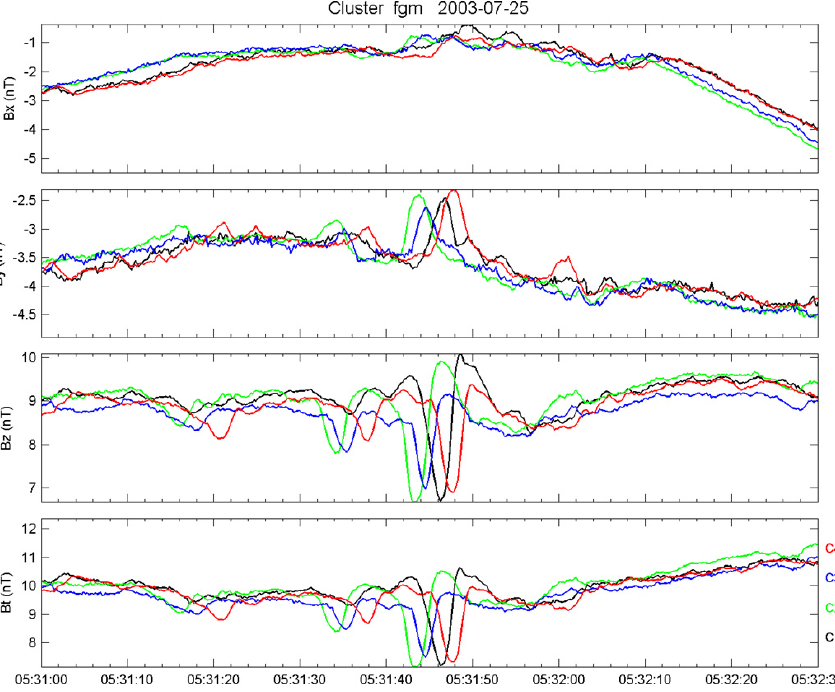
Fig. 2. From top to bottom panels: The GSM X component; Y component; Z component of magnetic field; the magnetic field magnitude. Table 1. Timing velocities of the two boundaries of magnetic holes in Fig. 2. Date Selected